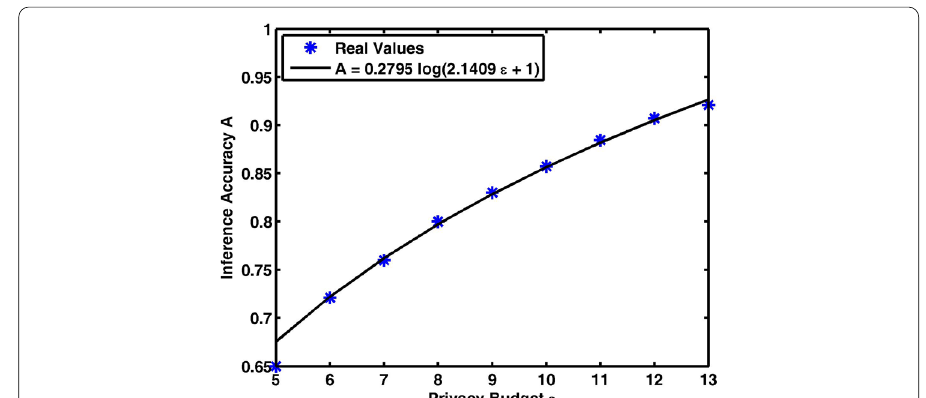
Fig. 5 Inference accuracy with respect to privacy budget